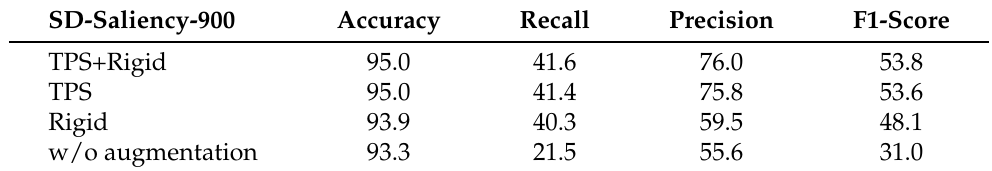
Table 4. Quantitative pixel-level defect detection results among different augmentation